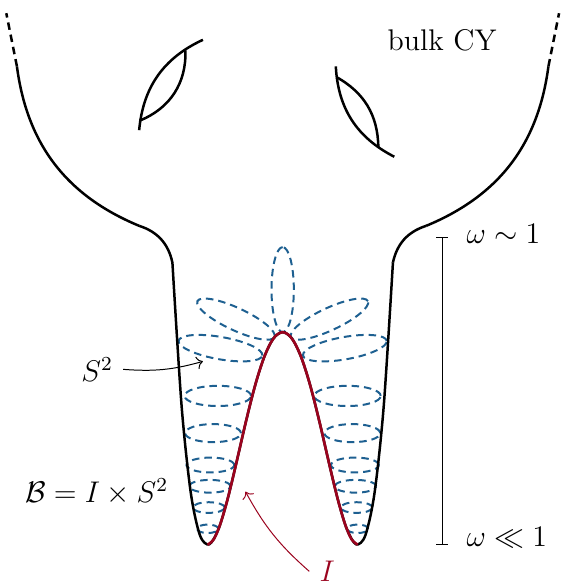
Figure 1 . Example of a double-throat system with one